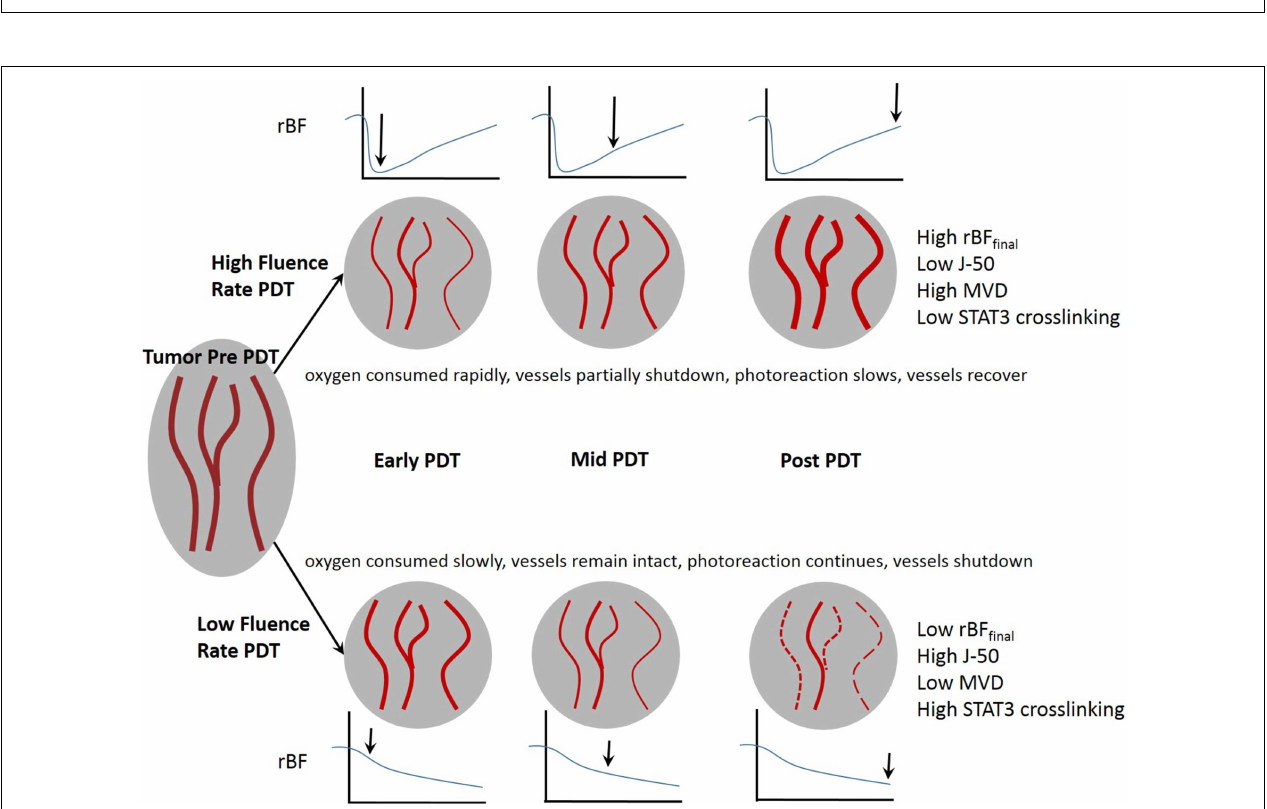
FIGURE 10 | The fluence rate of therapeutic light affects the tumor vasculature and can lead to effective or ineffective PDT.